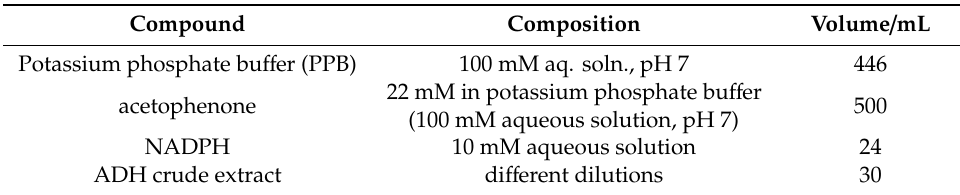
Table 2. Solutions for the photometer